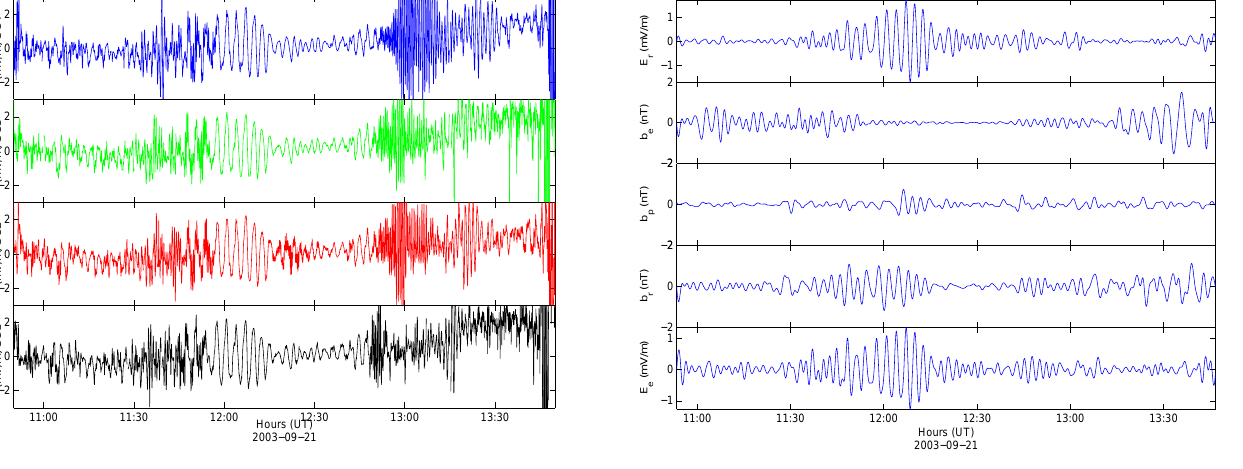
Fig. 10. As Fig. 5 but for the 21 August 2003 event.